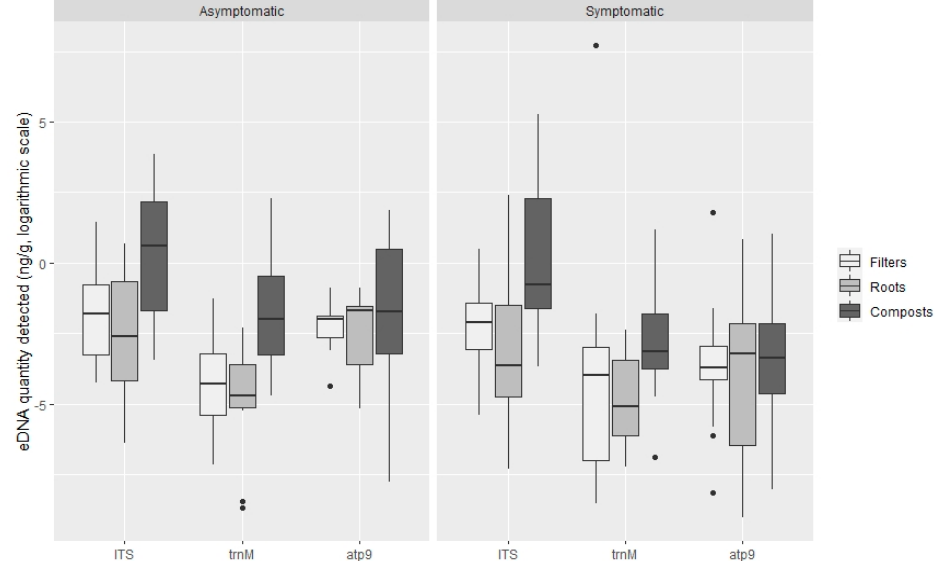
Figure 6. Quantification of oomycete eDNA (ng g − 1 , logarithmic scale) in symptomatic and asymp- tomatic plants by TaqMan probe. Boxplots indicate the 25th percentile (Q1, lower boundary), median (black line) and 75th percentile (Q3, upper boundary). Upper and lower whiskers indicate 10th and 90th percentiles. Dots above and below the whiskers represent outliers.